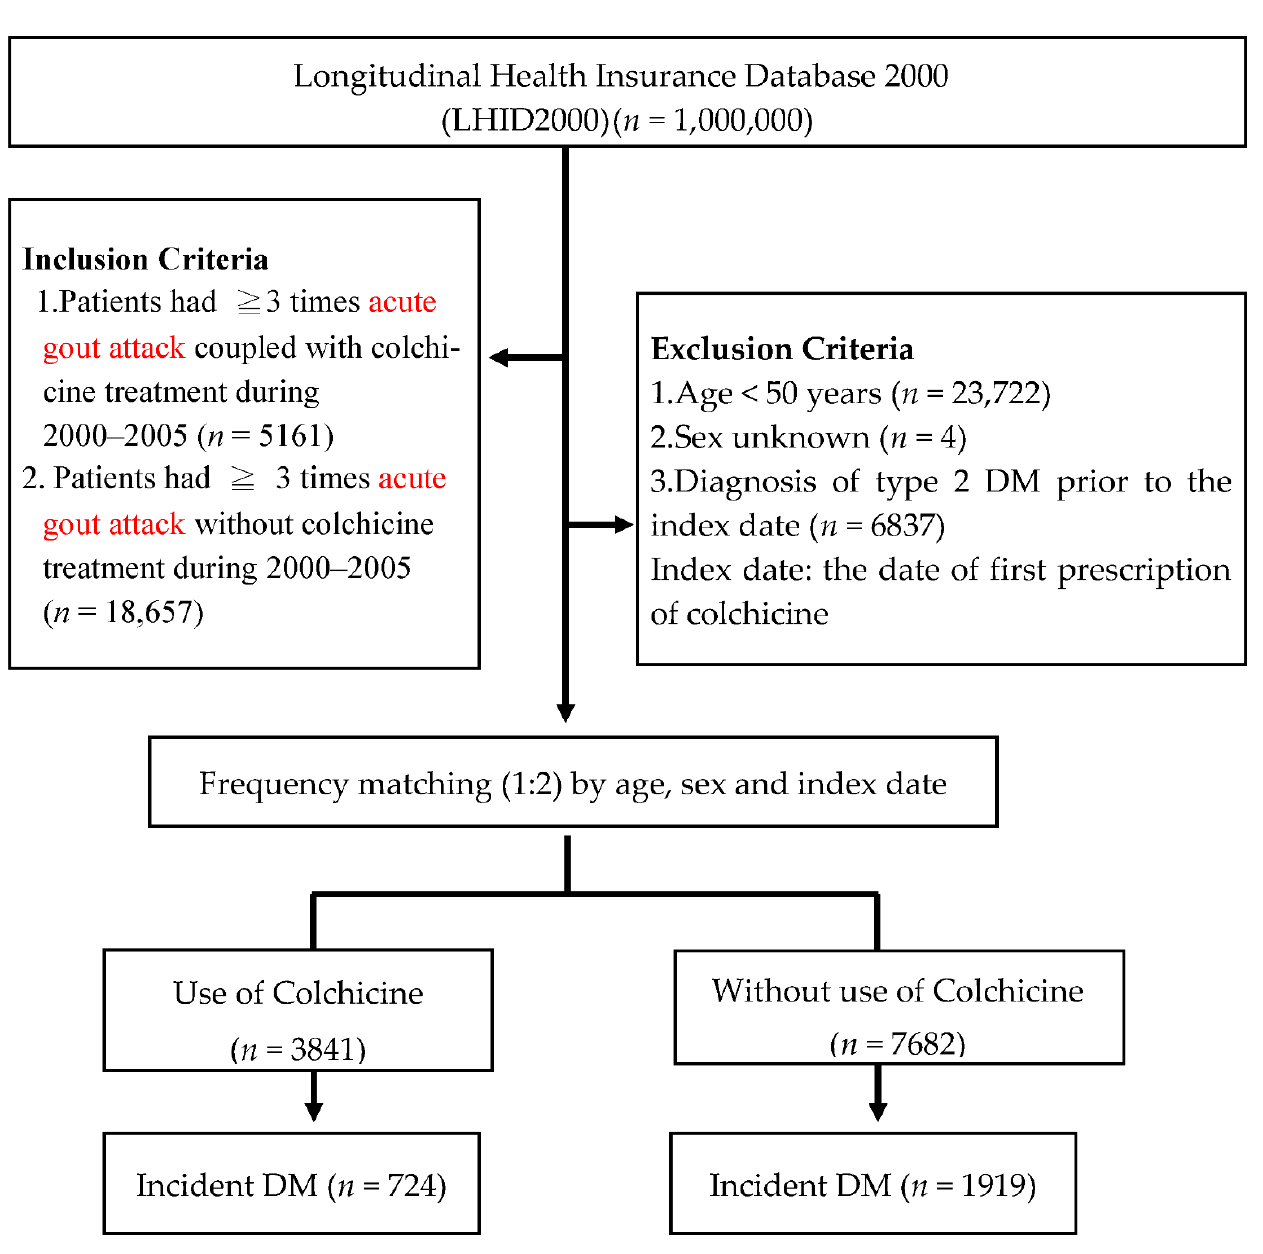
Figure 1. Flowchart of the study sample selection. DM, diabetes mellitus.